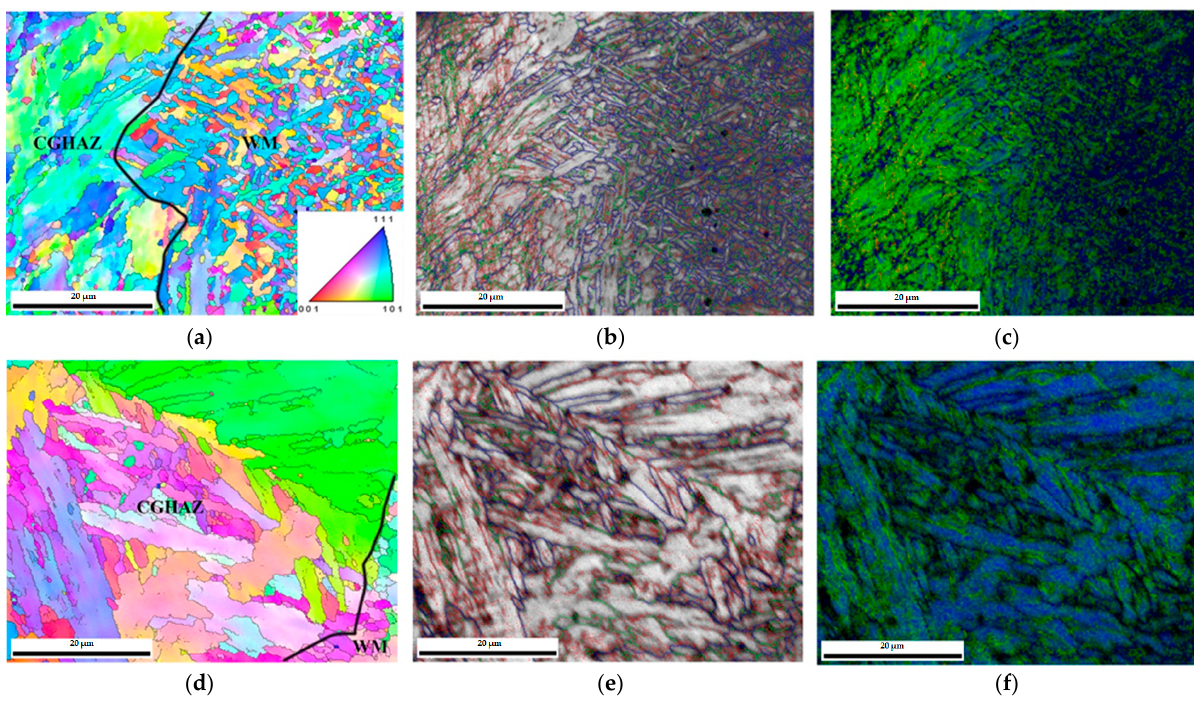
Figure 6. EBSD analysis of pre-fabricated crack tips under two heat inputs: ( a – c ) IPF map, size-angle grain boundary distribution map and KAM map for ultra-low heat input; ( d – f ) IPF map, size-angle grain boundary distribution map and KAM map for conventional heat input.